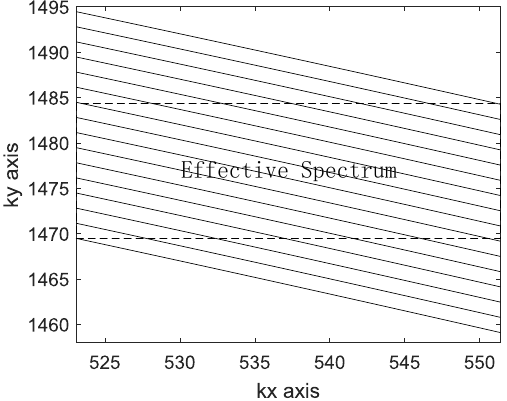
Figure 5. Spectrum of traditional interpolation.